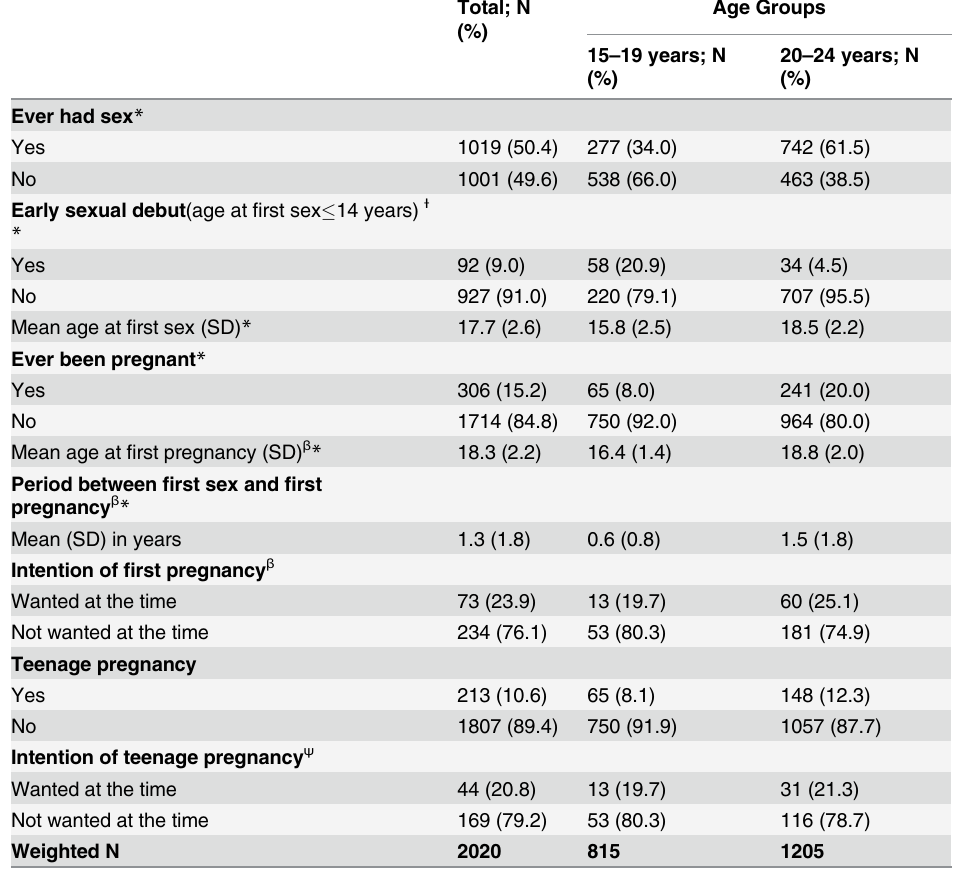
Table 2. Prevalence of sexual and reproductive behaviors among never-married women aged 15 – 24 years in urban Kenya.